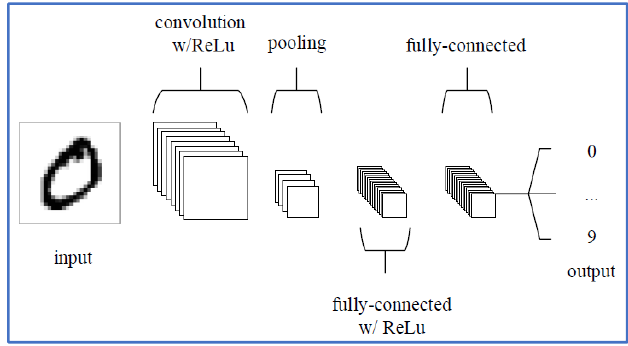
Figure 1. A simple CNN (Convolutional Neural Network) architecture.